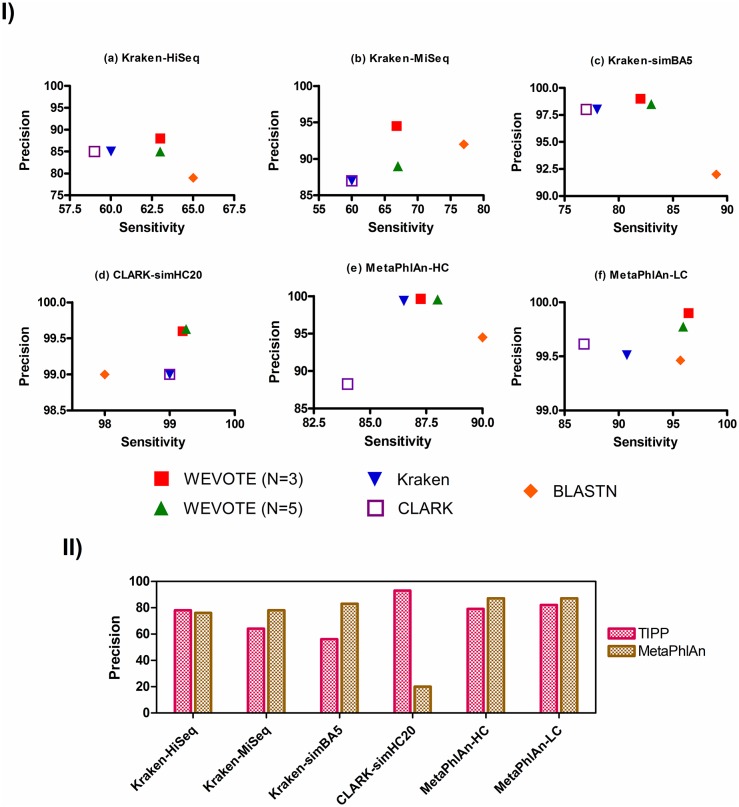
The sensitivity and precision at the species levels sub-panel (I) shows the sensitivity and precision of tools developed to identify every read; Kraken, CLARK, BLASTN, and WEVOTE. sub-panel (II) shows the precision of marker-based tools; TIPP and MetaPhlAn. The MetaPhlAn-HC and MetaPhlAn-LC datasets are the average of two HC and eight LC datasets, respectively.